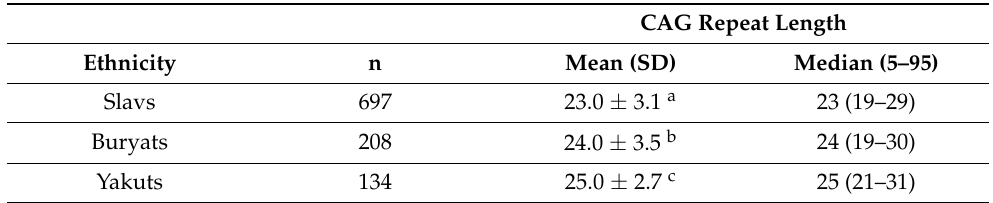
Table 3. CAG repeat length in male subgroups of different ethnicity.